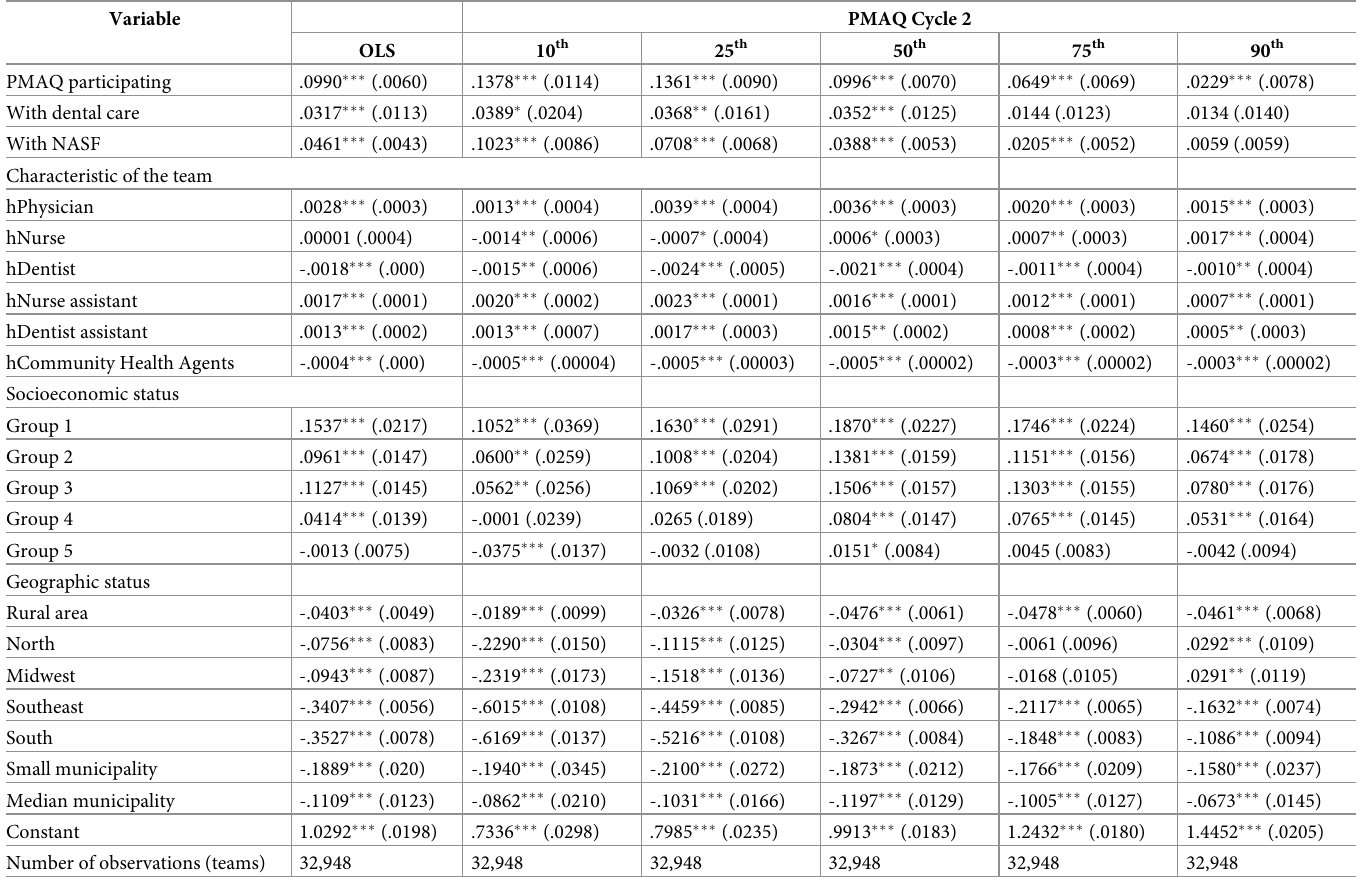
Table 2. Results from the OLS and QR models for antenatal consultations in the 2 nd cycle of PMAQ, Brazil.